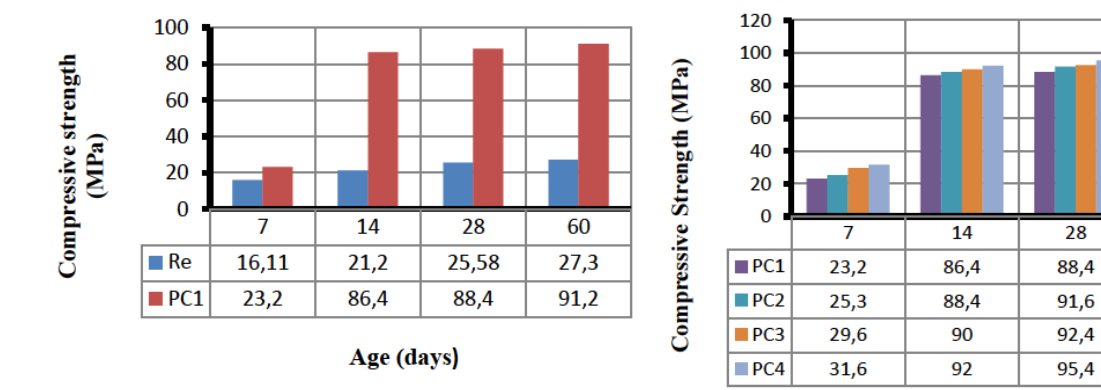
Figure 1: Influence of Epoxy on Compressive Strength of Polymer Concrete with Age